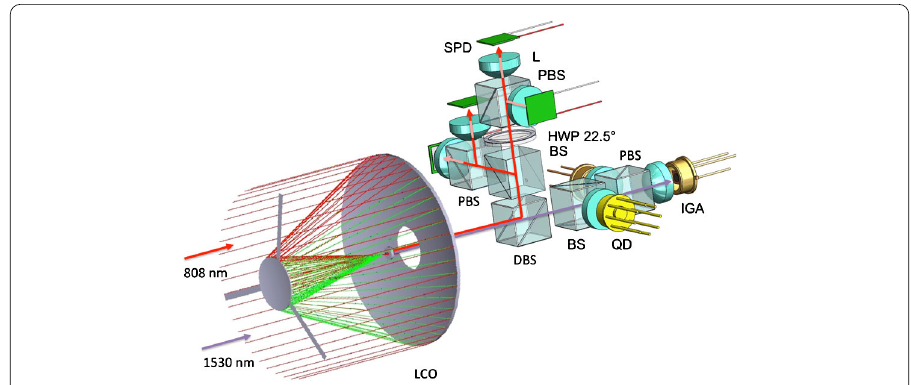
Figure 4 Schematic representation of the optical module. The OGS beacon laser at 1530 nm is collected by the main telescope (LCO). After separation by a dichroic mirror (DBS) it is split, with part being send to the beacon polarization analyzer (consisting of a polarizing beam splitter (PBS) and two detectors), and part being focused onto a quadrant detector (QD). The quantum channel light at 808 nm collected by the main telescope is sent towards a 4-detector polarization analyzer that includes two polarizing beam splitters (PBS), one for the {HV} basis, the other for the {DA} basis, and one half-wave plate (HWP) that rotates the polarization by 45 ◦ for the {DA} basis. The {HV} versus {DA} basis choice occurs randomly in the beam splitter (BS). Not shown are the corner cubes that retro-reflect the OGS beacon laser at 1560 nm, and the small diameter telescope that directs the satellite’s beacon laser at 1530 nm towards the OGS. The telescope and